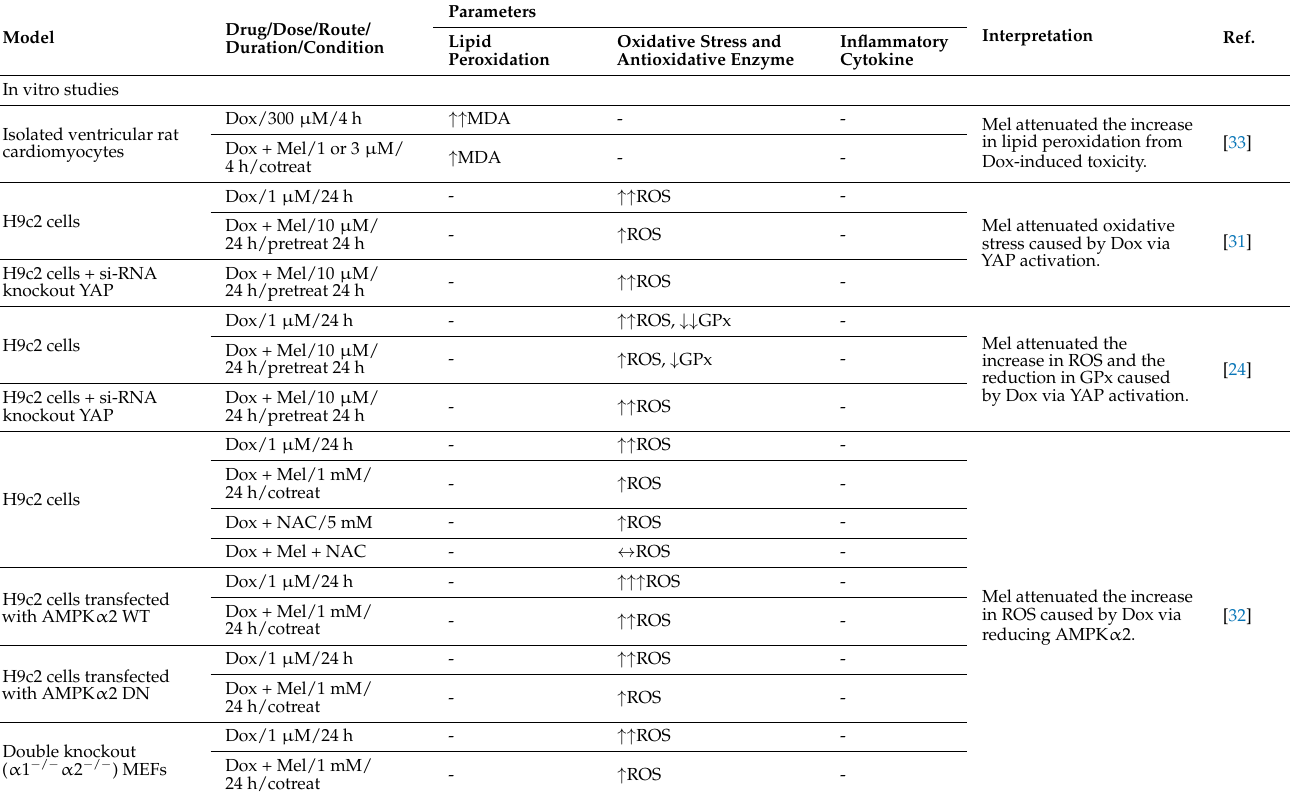
Table 1. Effects of melatonin on oxidative stress and inflammatory cytokines in doxorubicin-induced cardiotoxicity: evidence from in vitro and in vivo